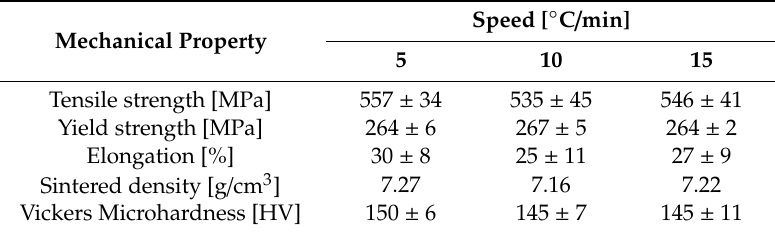
Table 2. The e ff ect of sintering speed on mechanical properties of AW based sintered parts.